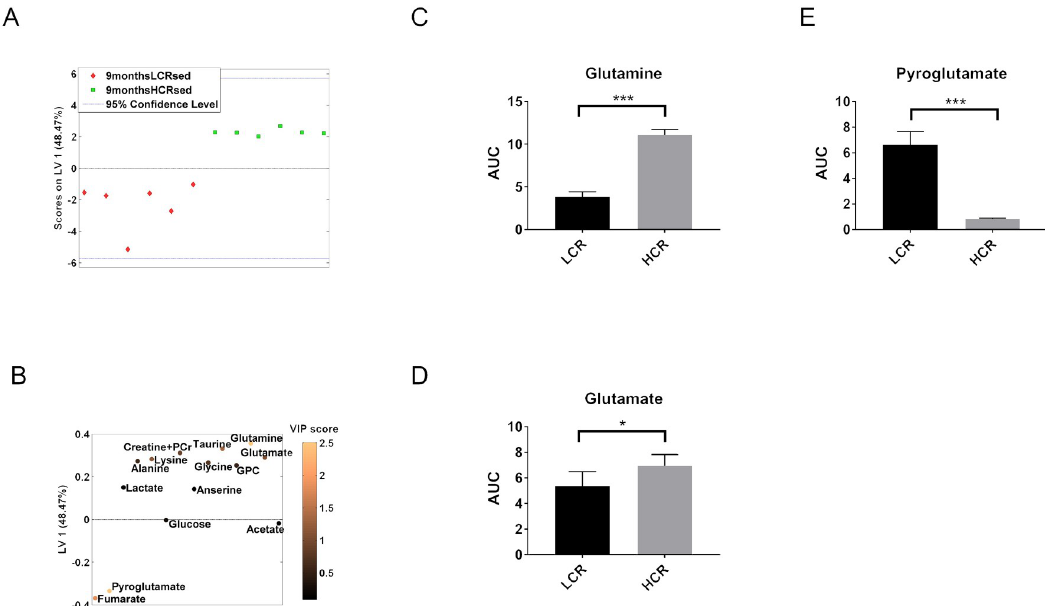
Fig 3. Multivariate and univariate analysis of metabolic profiles from LCR sedentary and HCR sedentary rats at 9 months of age. ( A ) PLS-DA score of sedentary 9 months rats showed a significant difference between LCR sedentary and HCR sedentary rats (permutation test, P = 0.04). ( B ) Loading variable 1 (LV1) was used to create the model. Contribution of each metabolite to the model is illustrated by colour, where a lighter shade indicates a greater VIP score and greater contribution to the model. ( C, D, and E ) Pairwise comparison between LCR sedentary and HCR sedentary at 9 months, of glutamine ( C ), glutamate ( D ) and pyroglutamate ( E ). P values: � , < 0.05; ��� , < 0.001.